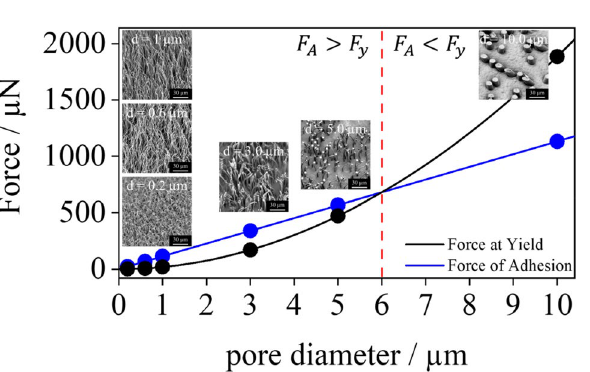
Figure 5. Schematic depiction of a stress strain-curve of a thermoplastic polymer and the hair formation process together with the corresponding SEM images of samples prepared according to scenarios ( B , E , F , G ) shown in the schematic; the grey arrow indicates the yield point, the black arrow the break point at which hair rupture occurs; ( A ) filling of the pore, ( B ) demolding with templating, ( C–E ) hair formation through cold drawing, ( F , G ) hair rupture.